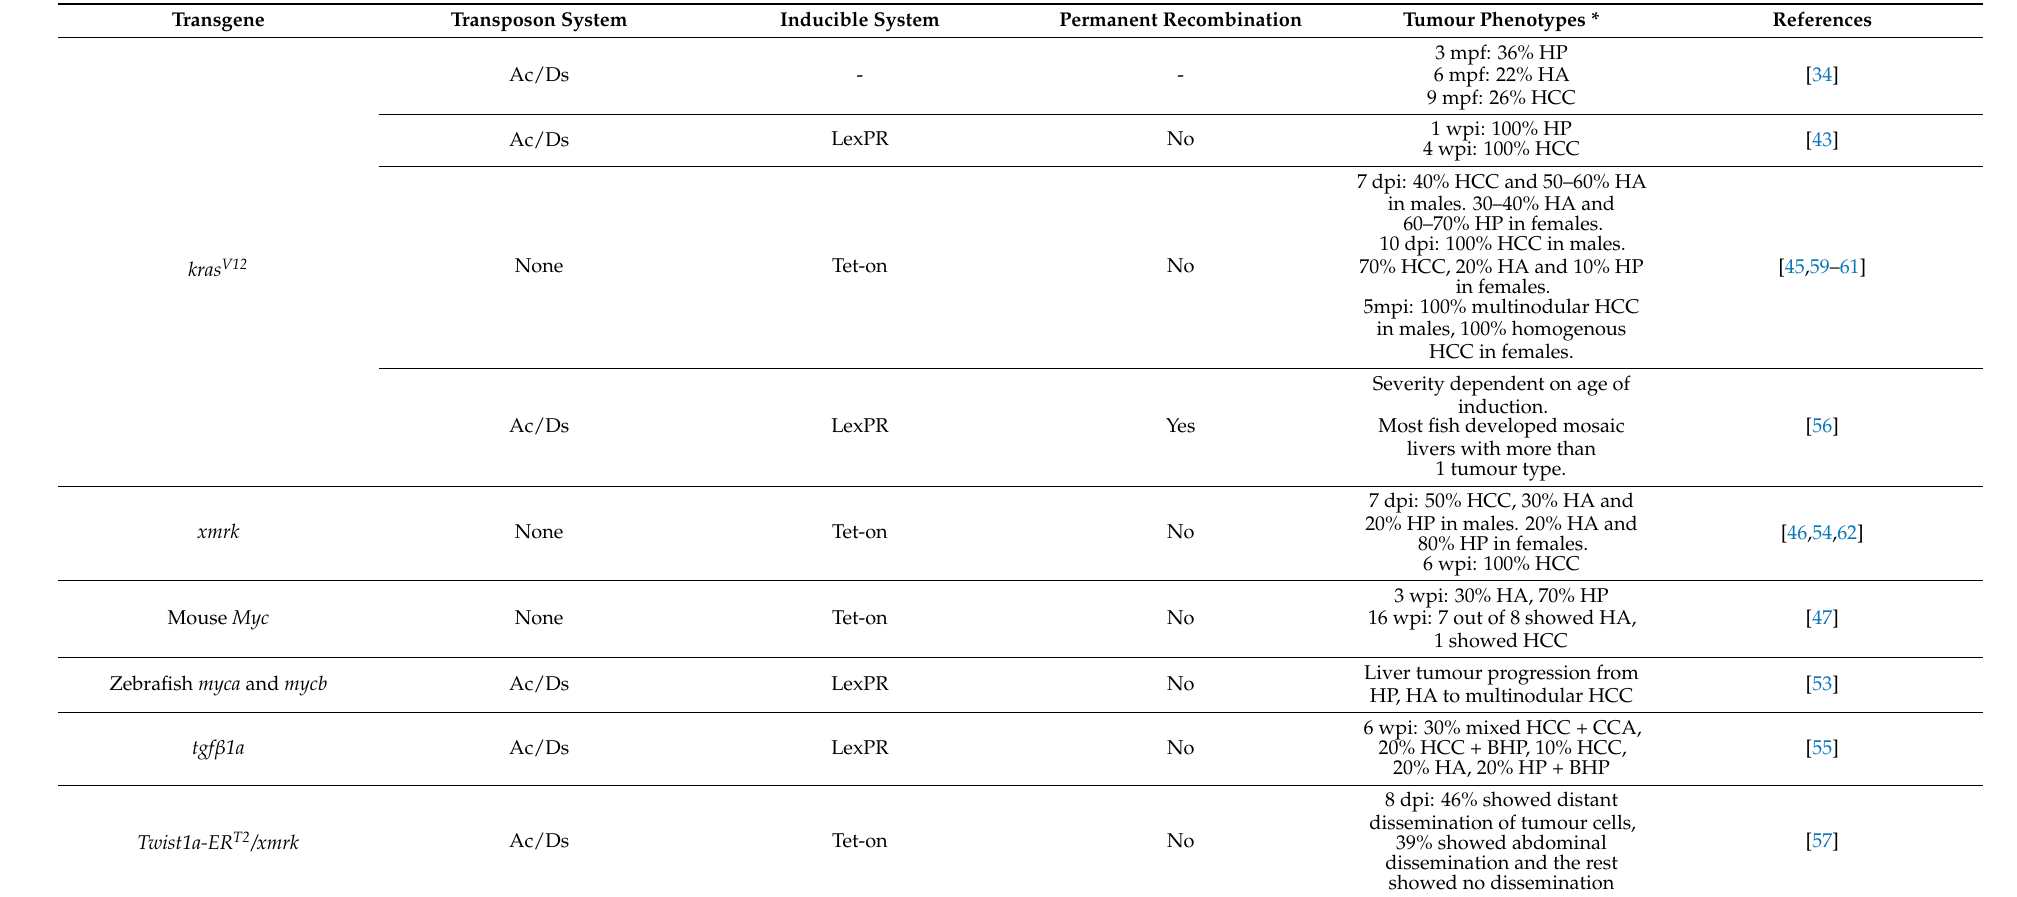
Table 1. Summary of our transgenic zebrafish models of liver